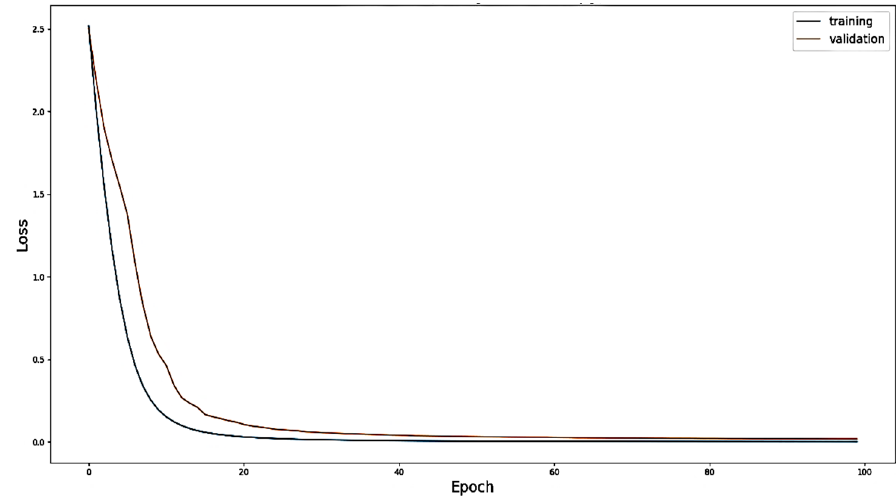
Figure 8. Training and validation model loss.